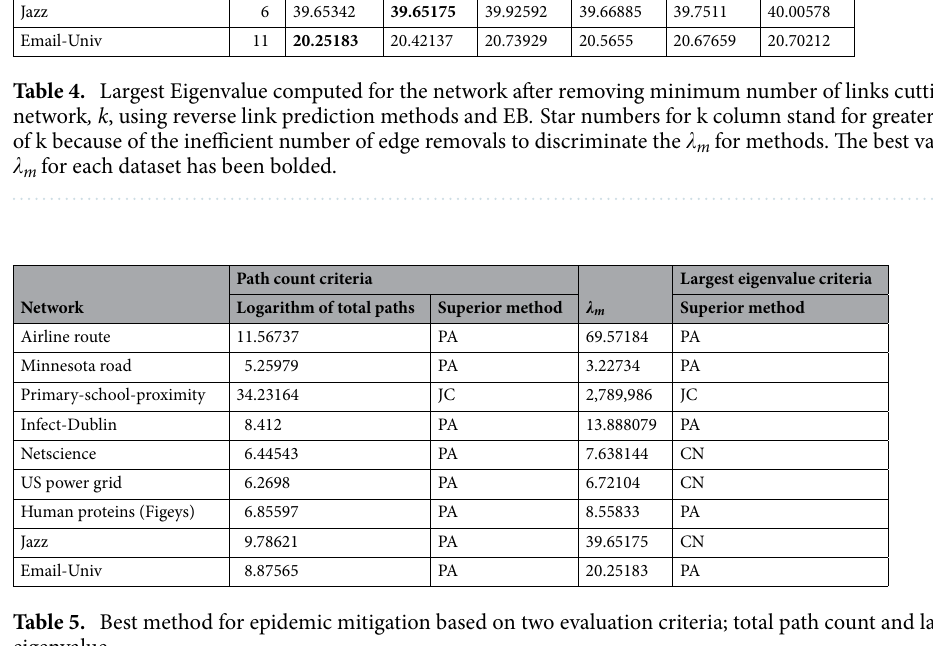
Table 5. Best method for epidemic mitigation based on two evaluation criteria; total path count and largest eigenvalue.